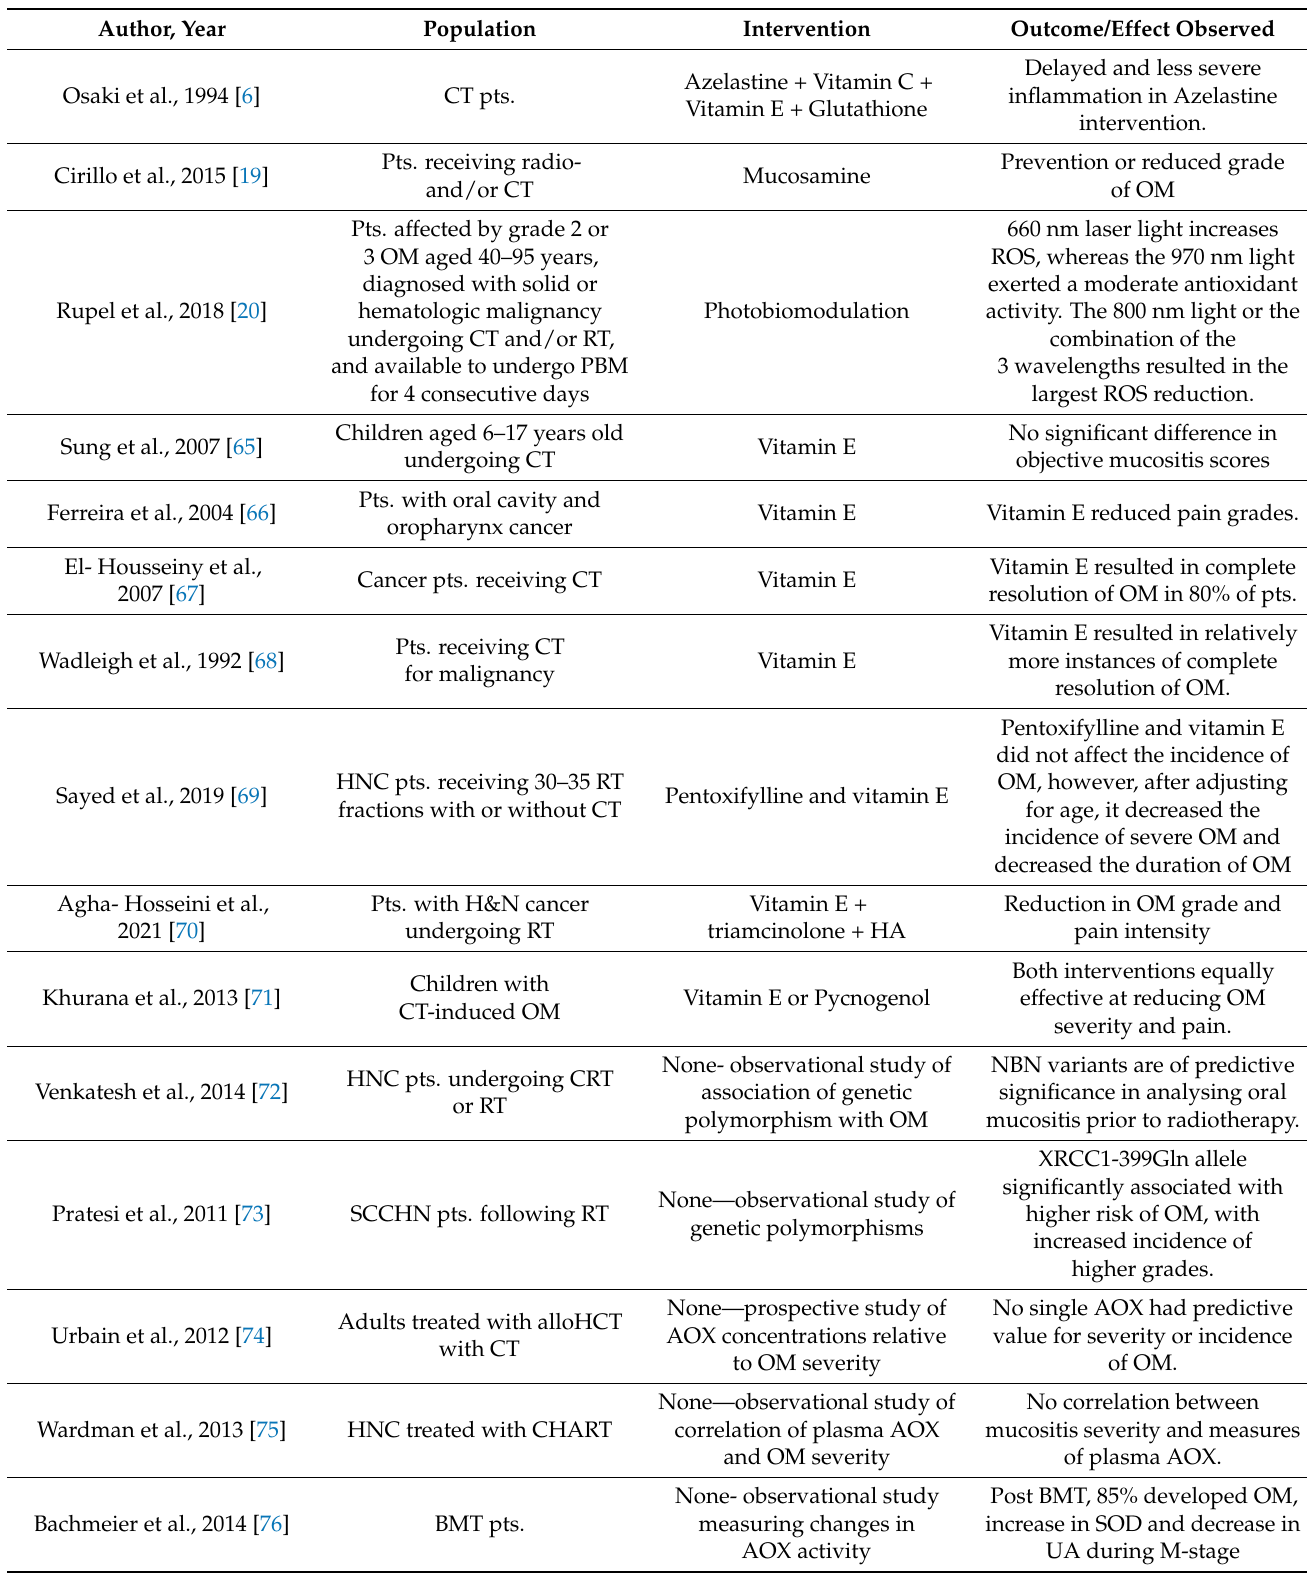
Table 3. Summary table of results of clinical